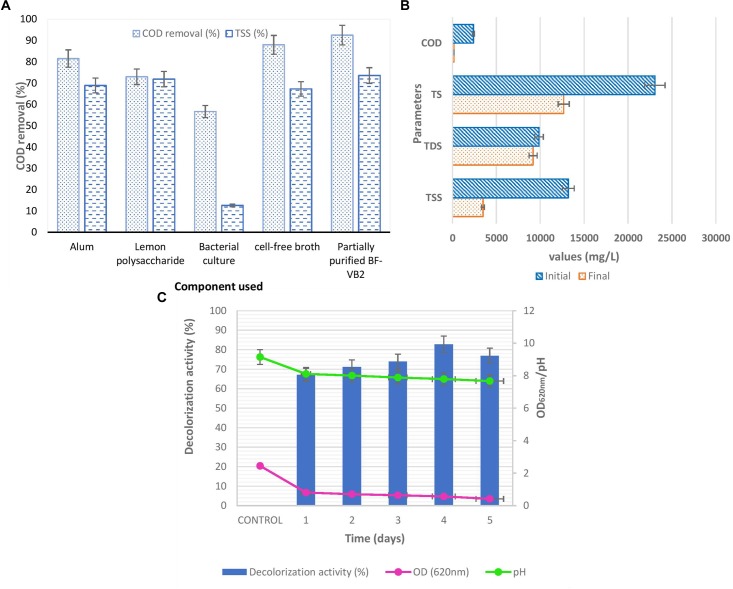
(A) Comparison chart of selected components for flocculation process of textile dyeing wastewater on COD and TSS removal. (B) Graph depicting activity of BF-VB2 in treating various parameters of textile dyeing industry wastewater. (C) Study of decolorization activity, pH and OD wrt time. Results are average value of triplicates and error bars represent standard deviation.